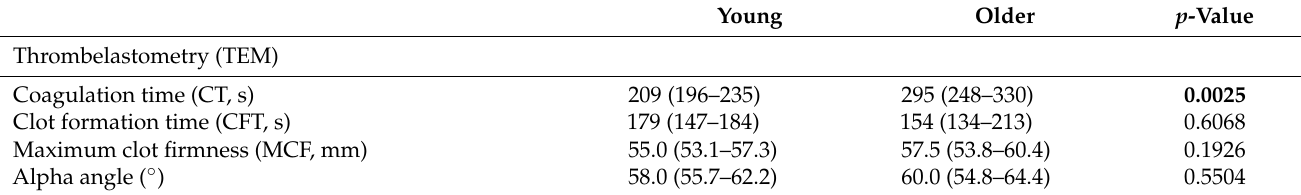
Table 2. Coagulation values prior to orthostatic challenge. Baseline levels of coagulation values in young (n = 20) and older (n = 22) participants. Data are expressed as median ± 95% CI. p -values were calculated by means of the Mann–Whitney